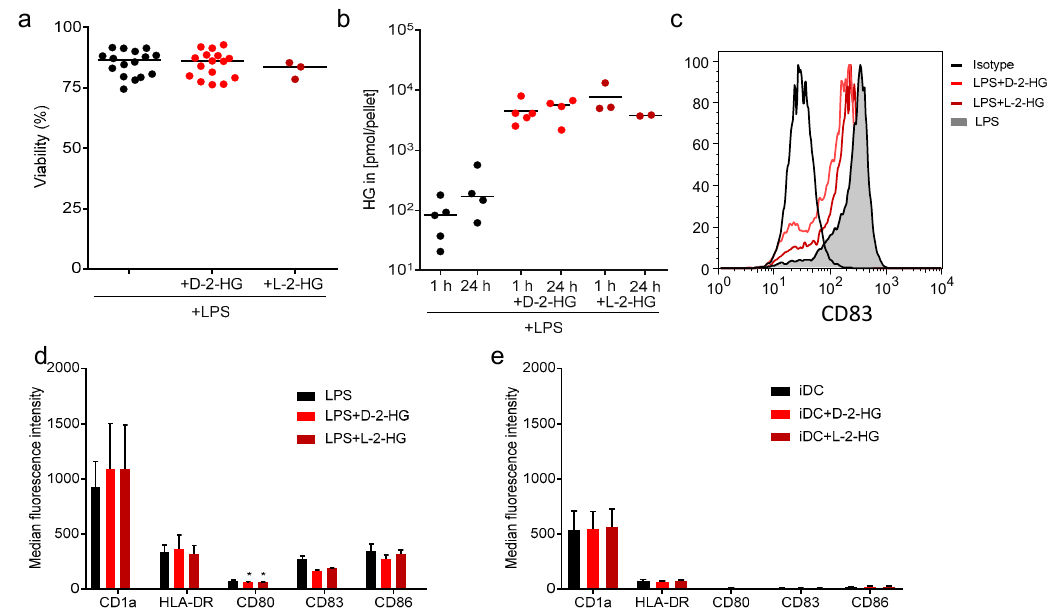
Figure 1. Uptake of 2-hydroxyglutarate (HG) by dendritic cells (DCs) has no impact on DC viability and maturation. ( a ) Human DCs were differentiated from elutration-separated monocytes in the presence of FCS, GM-CSF, and IL-4. On day seven, immature DCs were stimulated with 100 ng/mL LPS in the presence or absence of 10 mM 2-HG for 24 h and viability was analyzed using the CASY cell analyzer system. Data represent the median of 10 independent experiments with DCs from different donors. ( b ) Uptake of D-2-HG and L-2-HG by DC was analyzed after stimulation with 100 ng/mL LPS in the presence or absence of 10 mM 2-HG for 1 h or 24 h. Cells were washed with PBS and intracellular levels of 2-HG were analyzed by mass spectrometry. Statistical analysis was performed with the Wilcoxon-Test (** p ≤ 0.01). ( c , d ) The expression of typical DC markers on DCs stimulated for 24 h with 100 ng/mL LPS in the absence or presence of 2-HG was analyzed by flow cytometry. ( e ) As a control, DCs were cultured in the absence or presence of 2-HG without LPS stimulation.